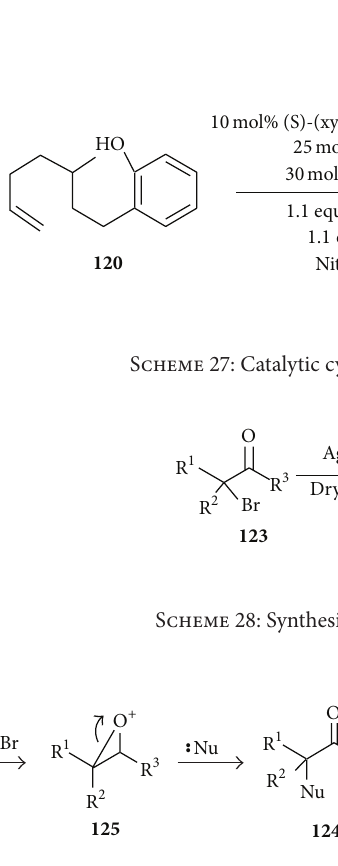
Scheme 29: Proposed reaction mechanism for 𝛼 -fluorocarbonyl compounds.